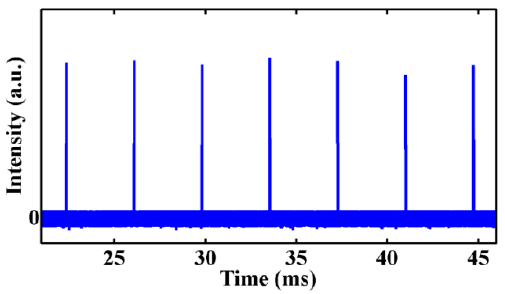
Figure 6. Pulse train recorded at 0.26 kHz PRF under 10 W of absorbed pump power.